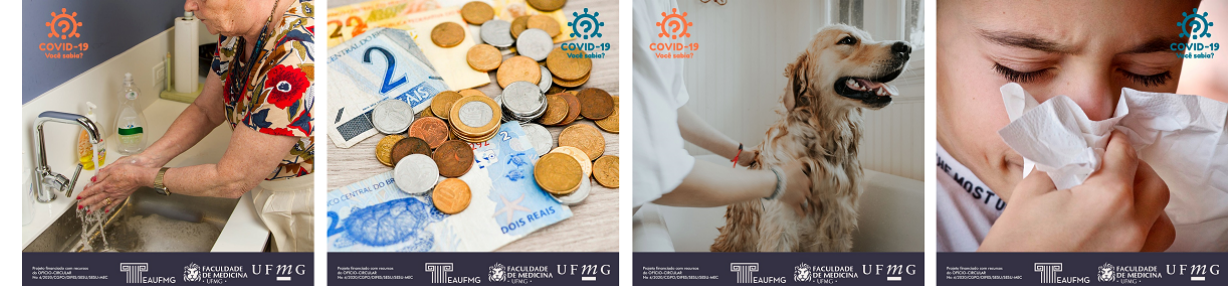
Figure 11. Examples of posts about the game on social